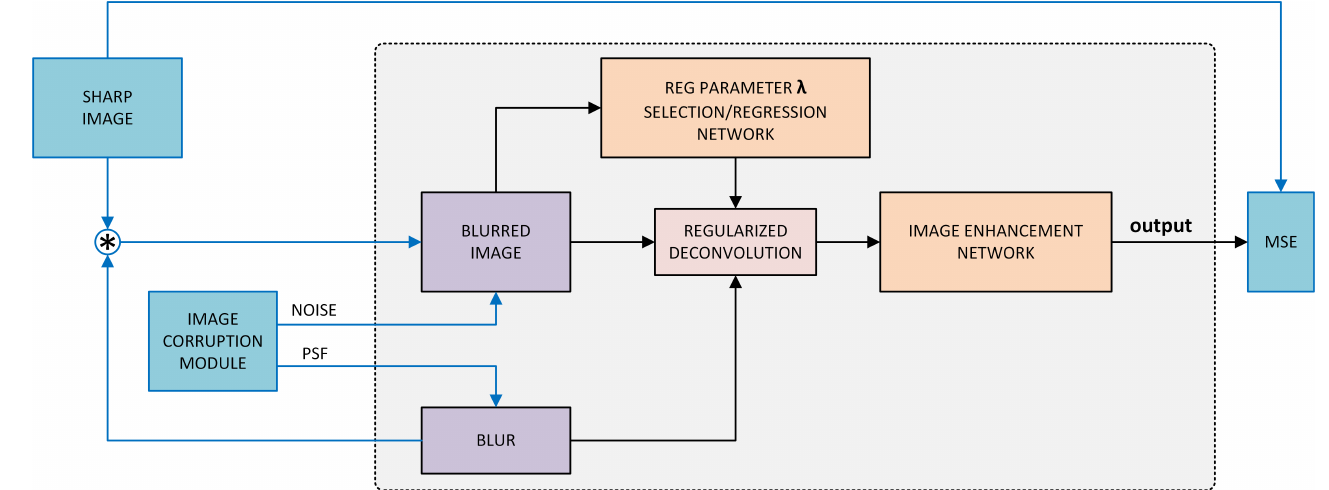
Figure 5. The proposed concept for noise-sensitive solution. Blue blocks/arrows describe the method for self-supervised end-to-end training of the system.